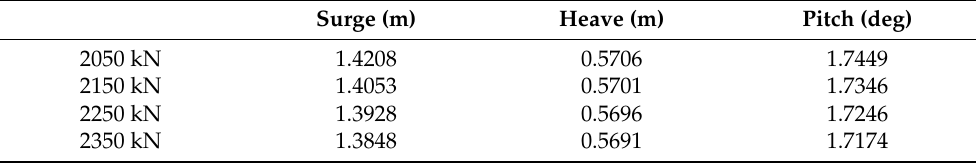
Table 13. Response RMS of different rope pretensions under storm self-survival conditions. Surge (m)